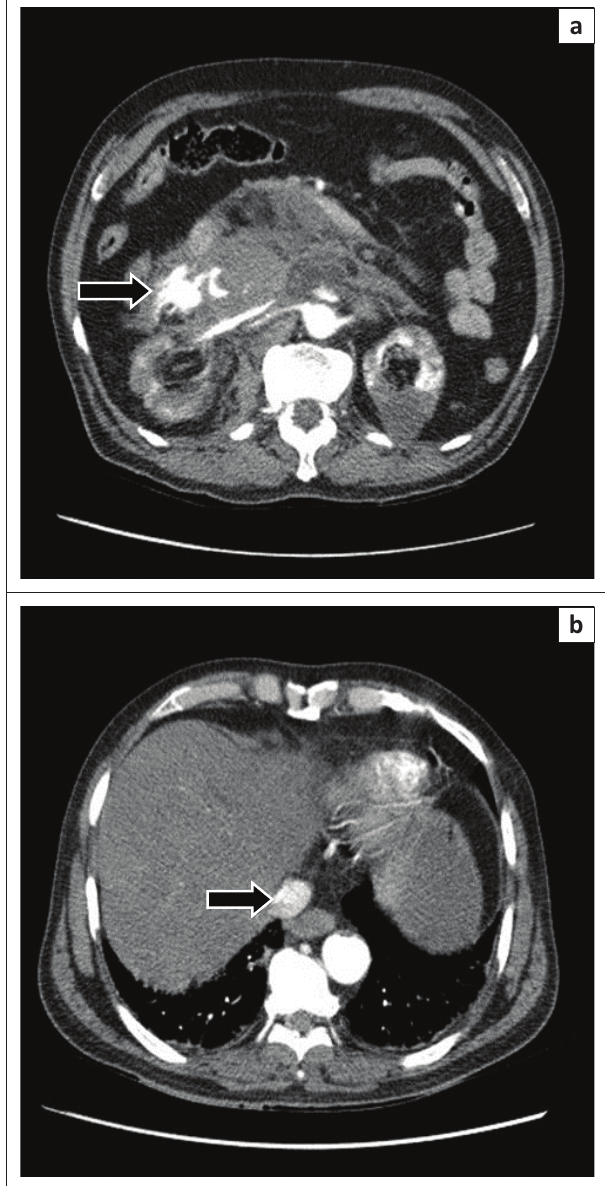
FIGURE 3: (a) Axial contrast-enhanced computed tomography scan demonstrating active extravasation of contrast into the peritoneal cavity (arrow). Contrast is also seen in the renal veins; (b) Contrast seen in the hepatic inferior vena cava (arrow) but with less attenuation (HU – 150) owing to reflux from right atrium.